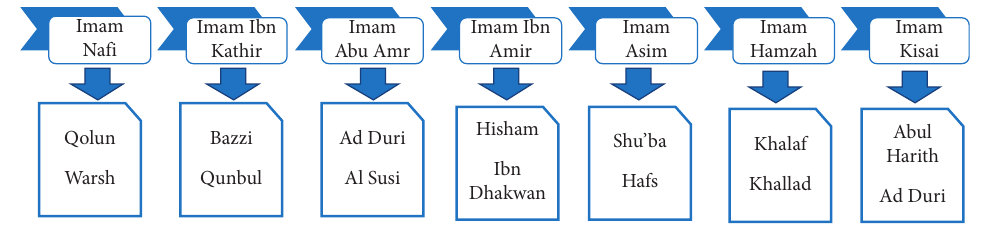
Figure 1: The seven Imams of Qiraat and their students ( rawis